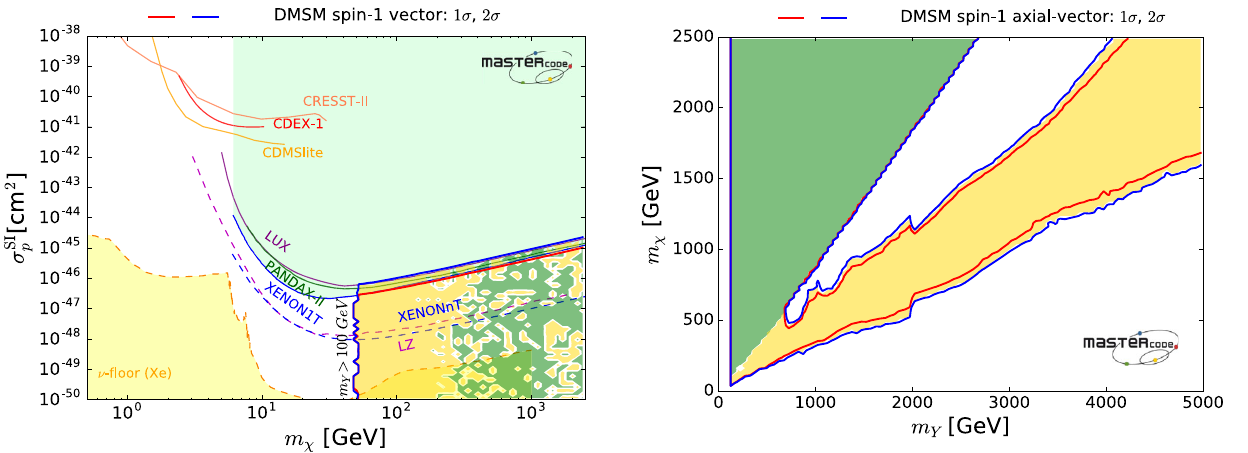
Fig. 7 The likelihood functions for g SM (left panel) and g DM (right panel) as functions of m χ in the vector-like model. We again use colour coding to illustrate the dominant mechanisms bringing the DM density into the allowed range: green for annihilation via t -channel χ exchange